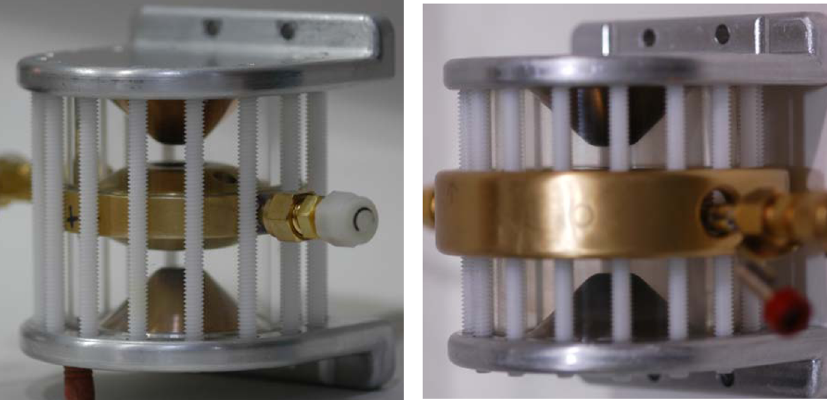
FIG. 6. (Color) Two views of the Sandia-designed switch. The brass doughnut outside the midplane was added to smoothly grade the electric fields around the outer edges of the